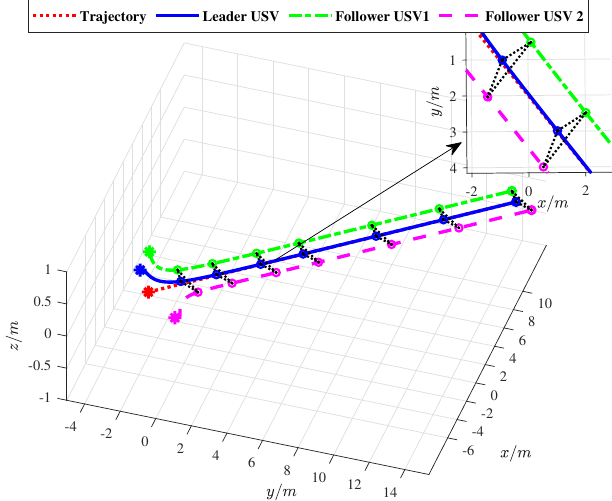
Figure 6. The beeline path of USV formation.